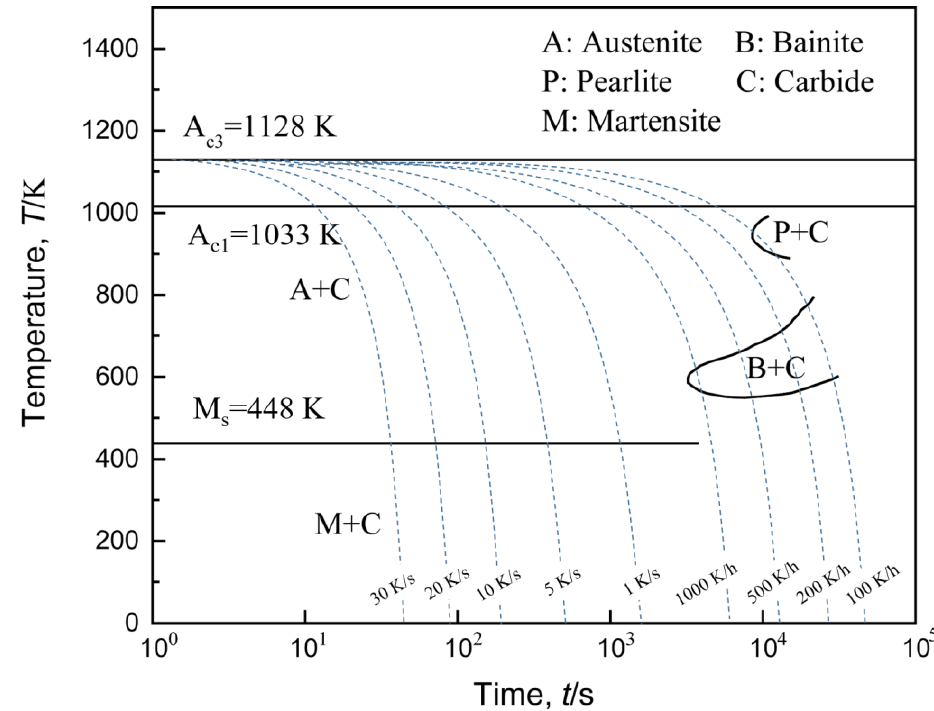
Figure 4. CCT diagram for AISI M42 HSS austenitized at 1473 K (1200 °C). The dotted lines mean different cooling rates range from 100 K/h to 30 K/s.